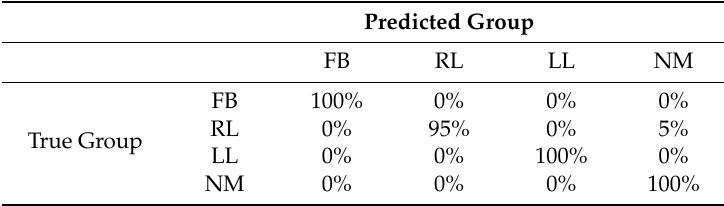
Table 4. Confusion matrix for the proposed